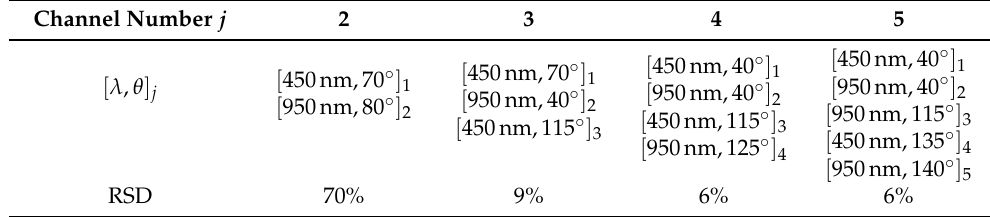
Table 3. The optimal optical